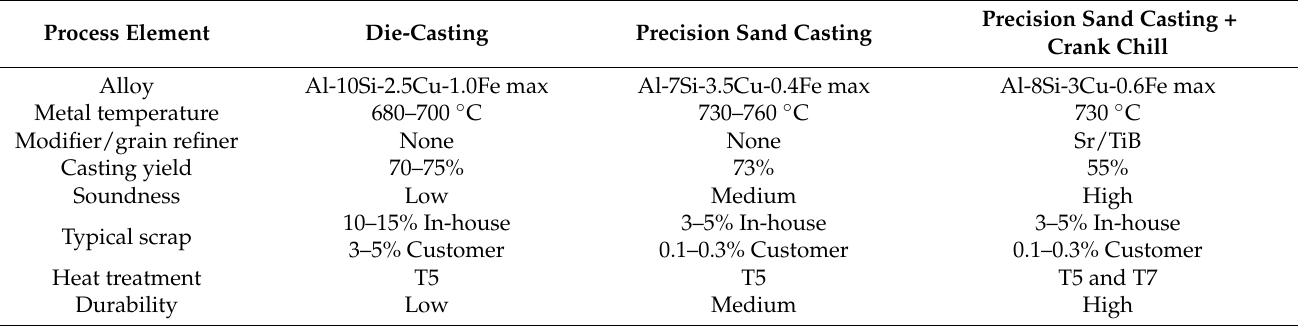
Table 1. Summary on the effectiveness of casting processes for V6 Al-Si alloy engine blocks